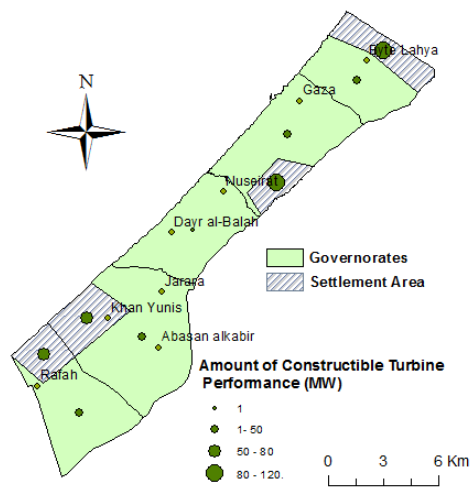
Figure 10. Area available for wind parks (ha) at the municipality and turbine performance (MW) corresponding to each area.